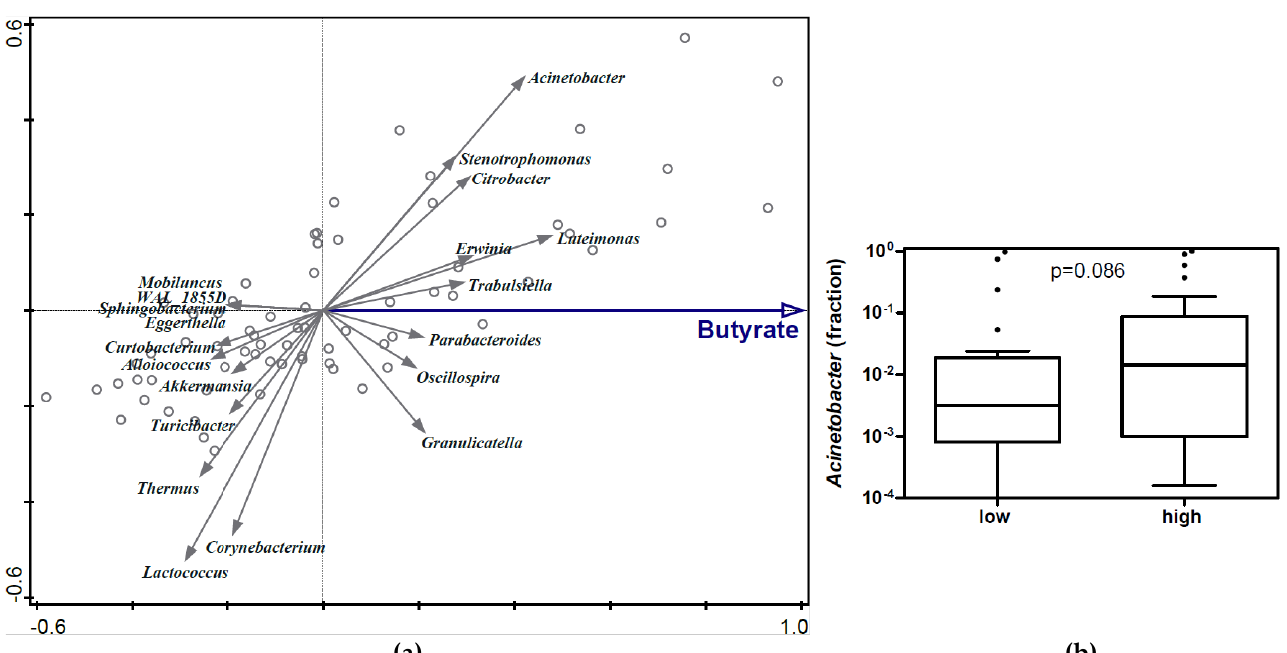
Figure 1. Associations between HM butyrate concentration and HM microbiota. ( a ) Redundancy analysis (RDA) on the genus level, assessing the associations between HM butyrate concentrations and HM microbiota composition. Genera were used as response data and butyrate concentration as explanatory data. Variation of HM microbiota composition explained by butyrate was 1.07% ( p = 0.036); ( b ) Relative abundance of Acinetobacter in HM microbiota composition based on HM butyrate concentrations. Mann – Whitney test was used to compare the relative abundance of Acinetobacter in HM between high- vs. low-butyrate groups (arbitrarily defined). Boxplots are displayed as Tukey whiskers.